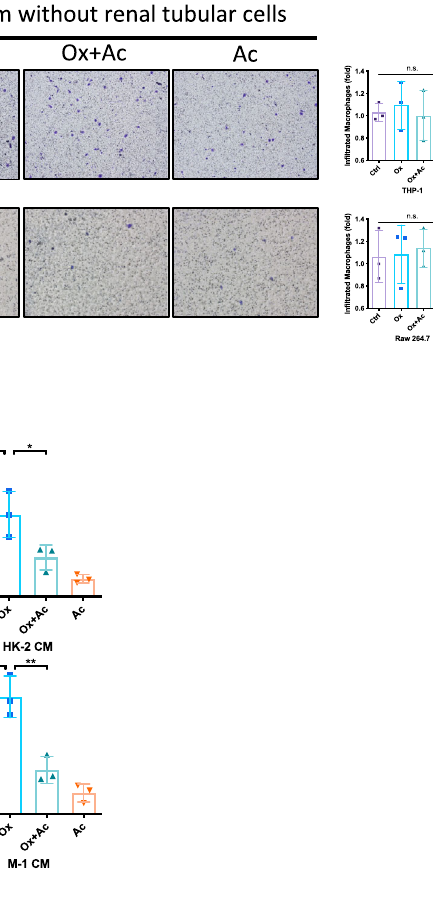
mutant MIF 3 ′ UTR construct, thus miR-493-3p could directly target MIF 3 ′ UTR to suppress its expression (Fig. 4j). Together, results from Fig. 4a – j suggested that acetate can suppress MIF protein expression via upregulating the miR-493-3p expression in the renal epithelial